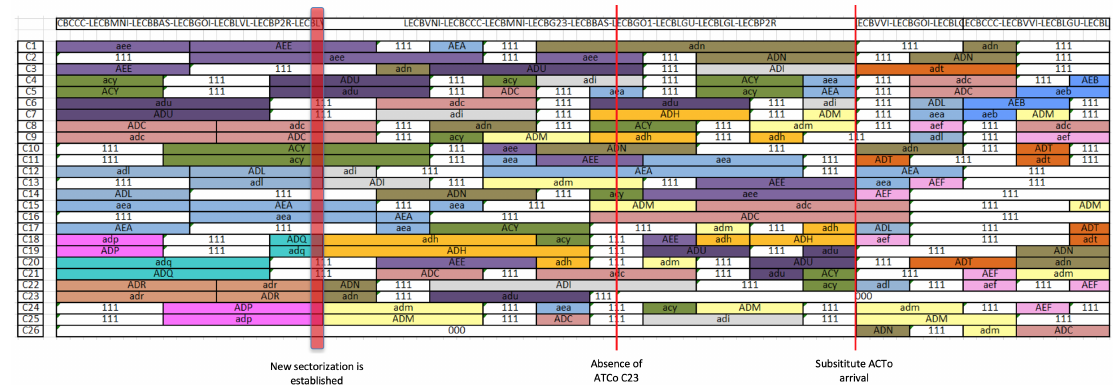
Figure 11. Optimal solution derived from Phase 2 using simulated annealing (SA).